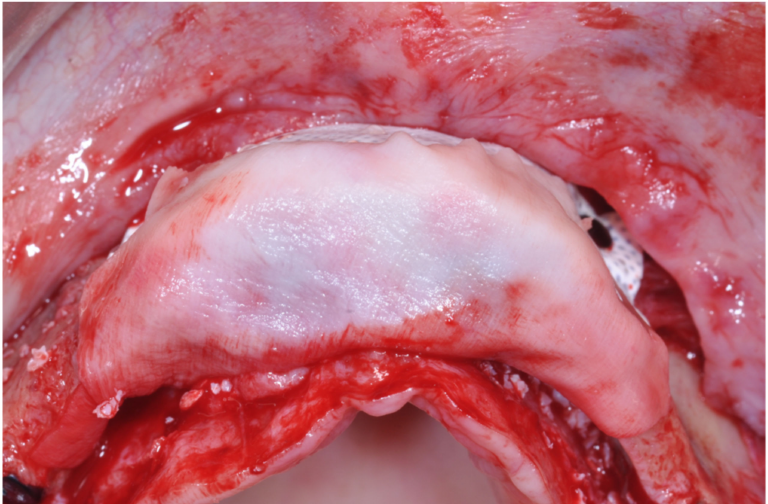
Figure 12. Placement of the collagen resorbable membrane covering the occlusal portion of the graft below the future suturing line.